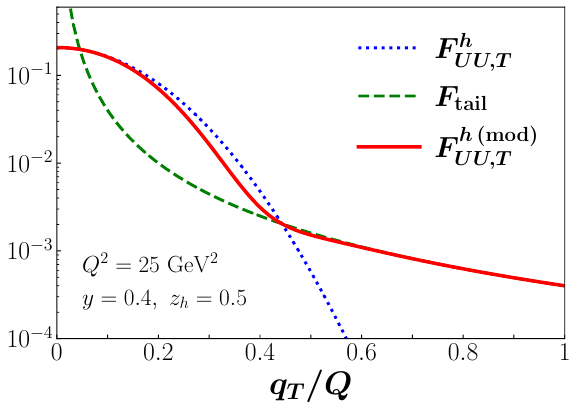
Figure 19 . Unpolarized SIDIS structure function F h as a function q T /Q , where q T = P hT /z , UU,T at fixed values of Q 2 = 25 GeV 2 , y = 0 . 4 , and z h = 0 . 5 . The unmodified function (dotted blue line) is taken from the JAM3D20 global QCD analysis [69], while the additional power-law tail contribution (dashed green line) distorts the region q T /Q > 0 . 5 by enhancing the modified F h (mod) UU,T (solid red line) to mimic QCD radiation effects in collinear factorization.